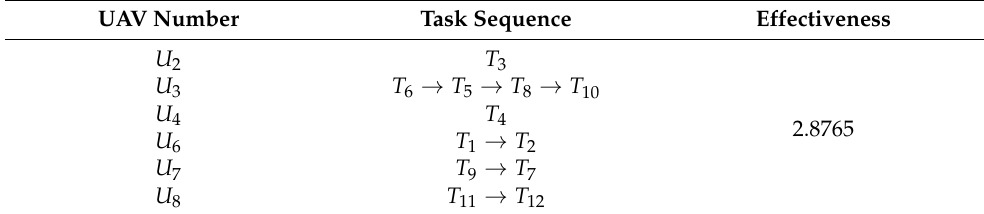
Table 12. Task allocation scheme after UAV failure.